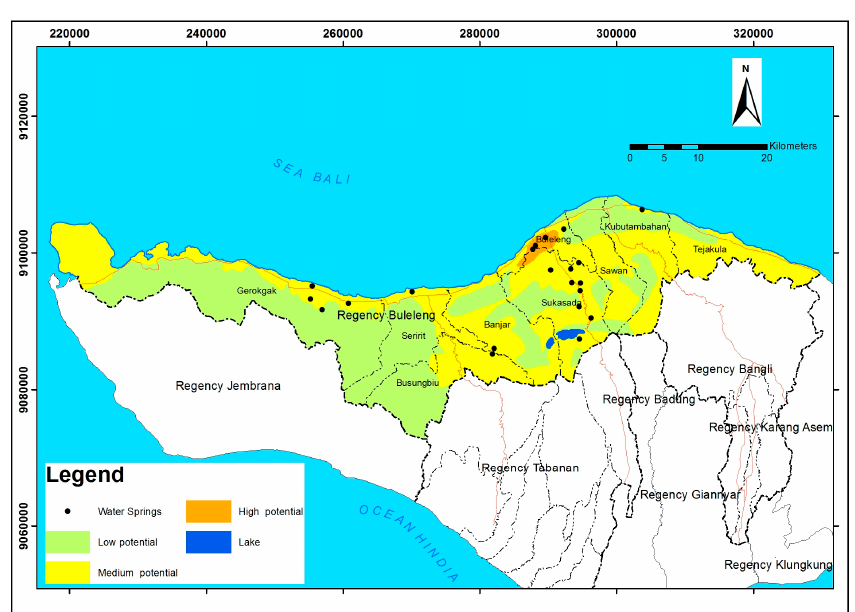
Figure 9. Groundwater potential on the study area.